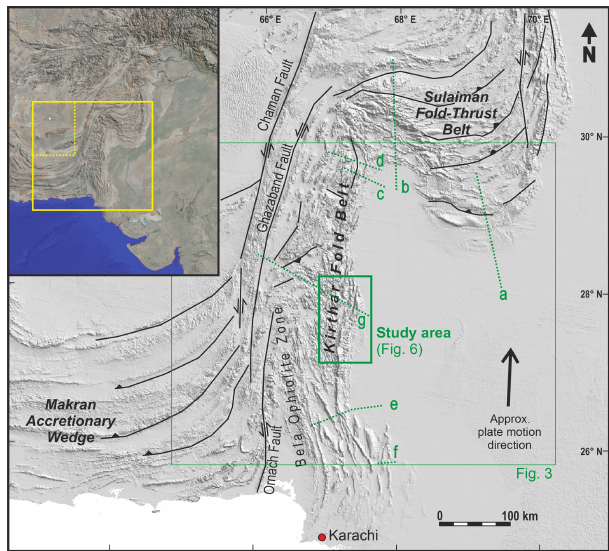
Figure 1. Simplified structural sketch of the wider Kirthar Fold Belt area on a shaded relief map. Location is indicated in the inset map. The approximate plate motion is from Mohadjer et al. (2010). Locations of sections in Fig. 2 are indicated: a: Jadoon et al. (1992), b + c: Banks and Warburton (1986), d: Szeliga et al. (2009), e: Fowler et al. (2004), f: Schelling (1999), g: this study.